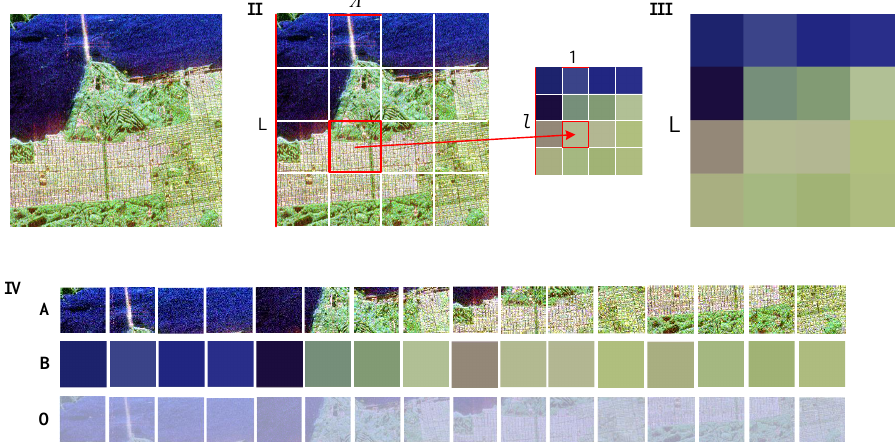
Figure 3. Schematic representation of the PolSAR image’s structural complexity. A PolSAR image of L × L pixels ( I ) is divided into blocks of Λ × Λ pixels ( II ). A renormalized image of l × l pixels is plotted, where l = L / Λ ( l = 4, Λ = 2 in this paper). The renormalized image is rescaled up to the initial image size ( III ). Vectors A and B are constructed from blocks of the initial and the renormalized images, respectively (IV). The scalar product of these vectors is used to define overlap O . For illustrative purposes, pixelwise products of A and B blocks are shown as vector O